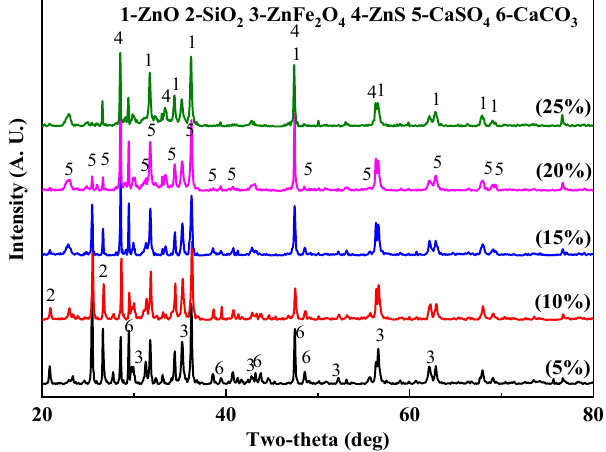
Figure 6. The effects of different doping concentrations of Na 2 O 2 on the XRD patterns of zinc calcines.